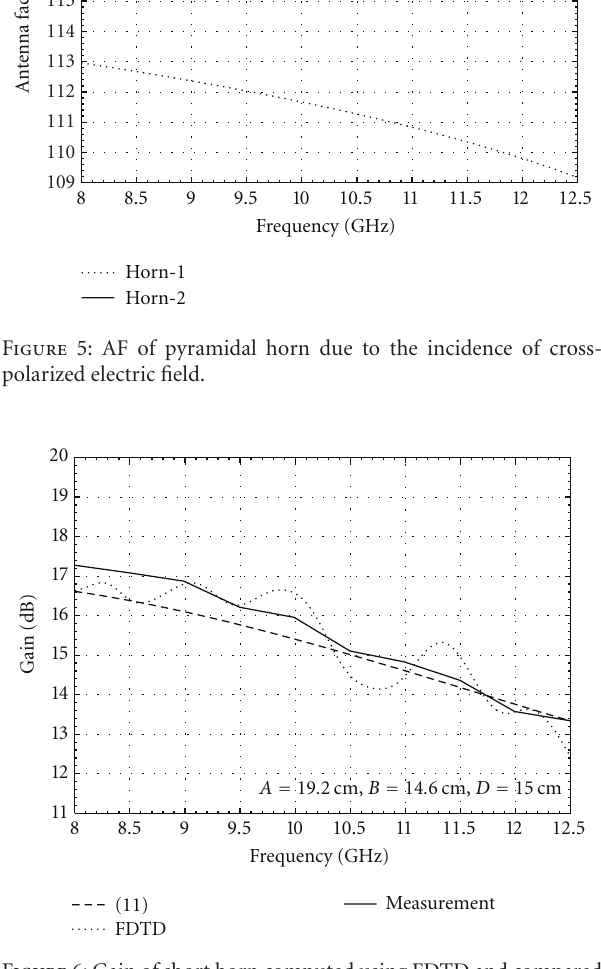
Figure 6: Gain of short horn computed using FDTD and compared with (11) and measurement of [9, Figure 2].